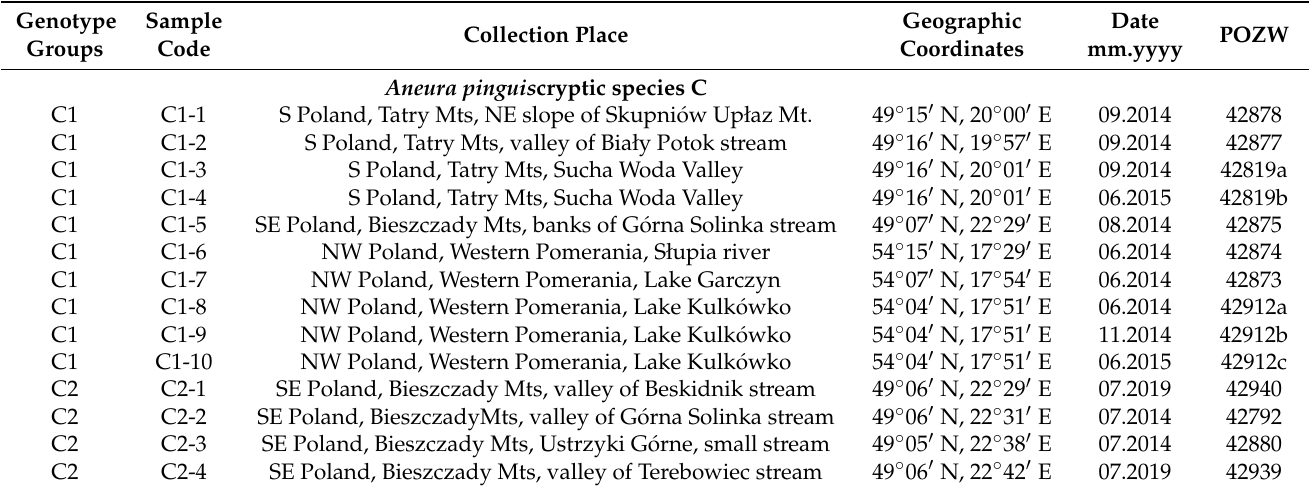
Table 1. Sampling data of Aneura species used for studies and numbers of POZW herbarium vouchers.